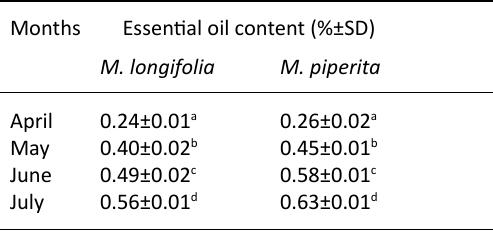
Table 1. The average essential oil yield (%) of M. longifolia and M. piperita from April to July month